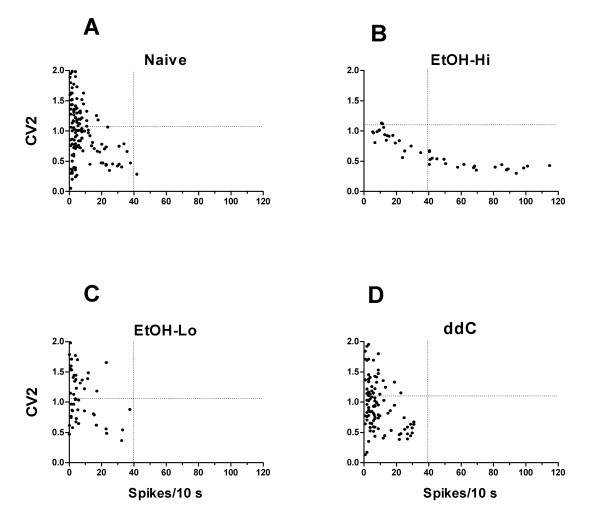
The Cv2 distribution of high firing fibers (B, n = 7) for EtOH group is markedly different from low firing fibers (C, n = 8) for EtOH group and control animals (A, n = 38) while they were similar between low firing fibers for EtOH group and controls. The Cv2 distributions were similar between ddC (D, n = 18) and controls.